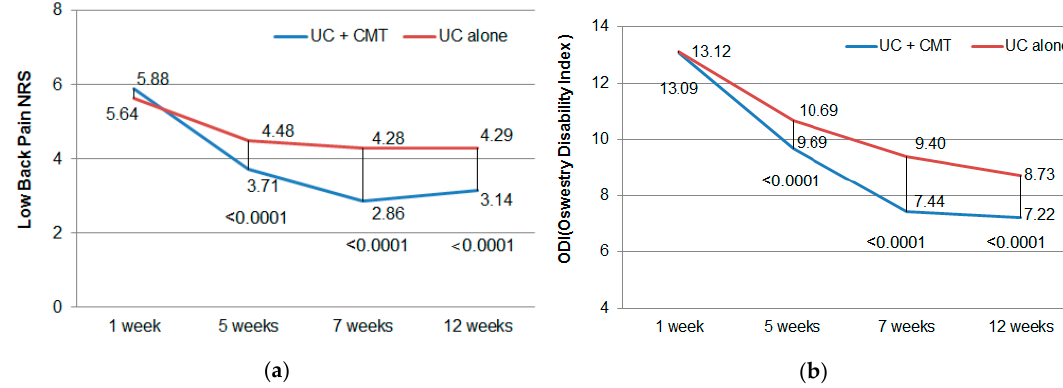
Figure 3. The changes in pain intensity of lower back pain and function by the Oswestry Disability Index at each endpoint. ( a ) The mean numerical rating scale (NRS) of lower back pain from baseline through 12 weeks of follow-up. Follow-up data were collected at 5, 7, and 12 weeks. ( b ) The mean Oswestry Disability Index (ODI) scores from baseline (1 week) through 12 weeks of follow-up. Follow-up data were collected at 5, 7, and 12 weeks. CMT: Chuna manipulative therapy; UC: usual care.